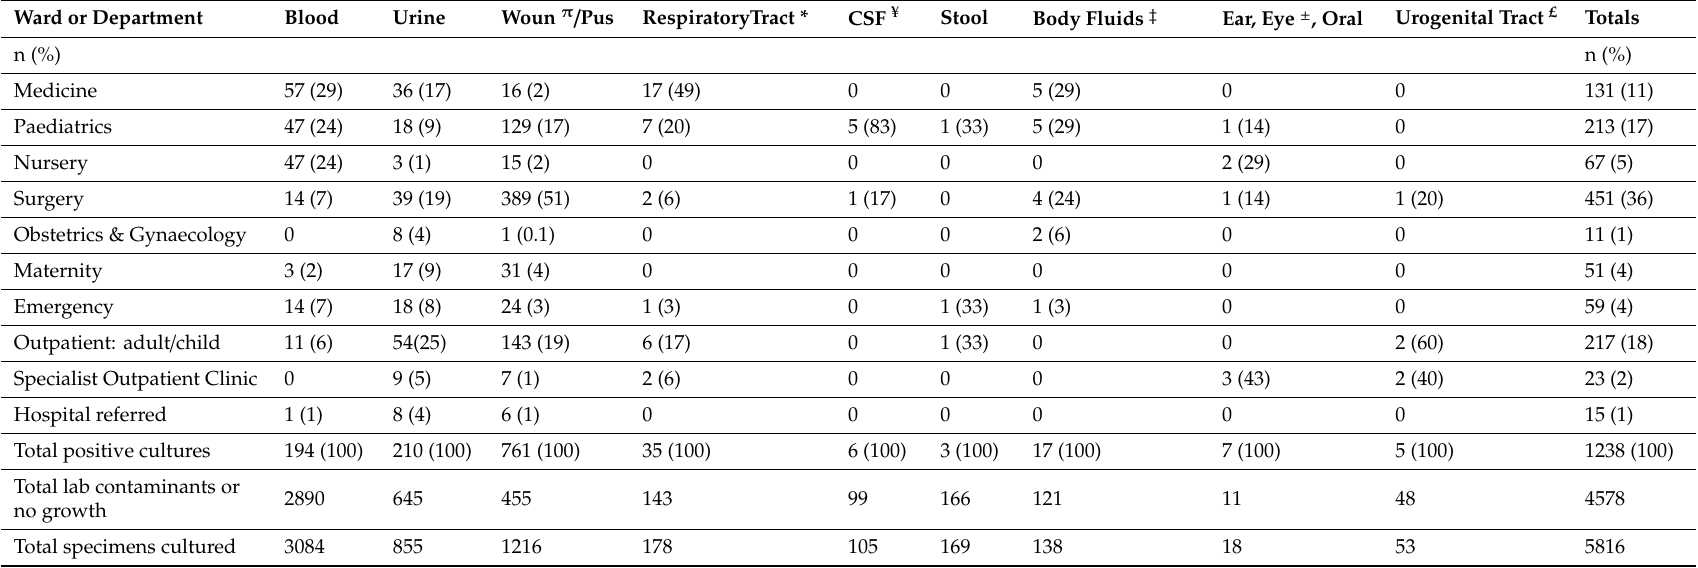
Table 1. Distribution of positive cultures by ward / department by specimen cultured at Vila Central Hospital (VCH): January 2017 to December